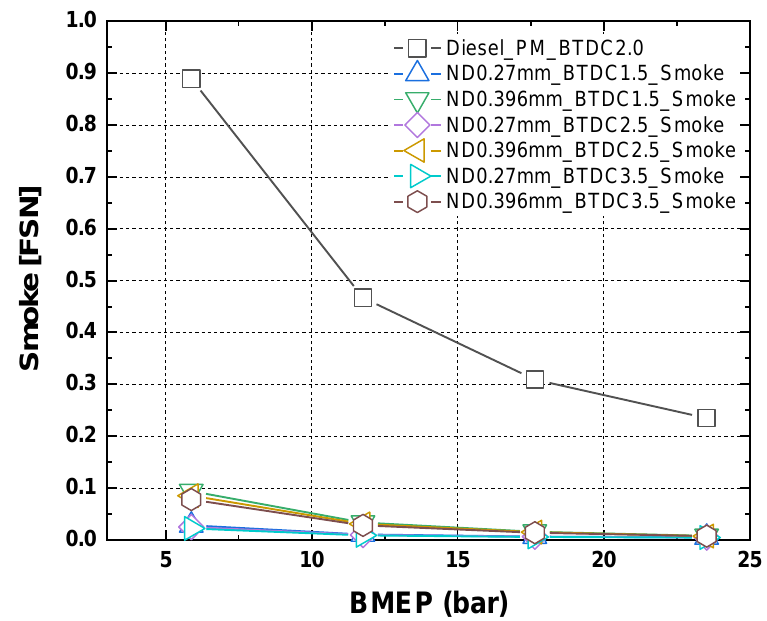
Figure 9. Characteristics of smoke emission versus start of injection timing and nozzle hole diameter for marine diesel fuel and DME fuel.